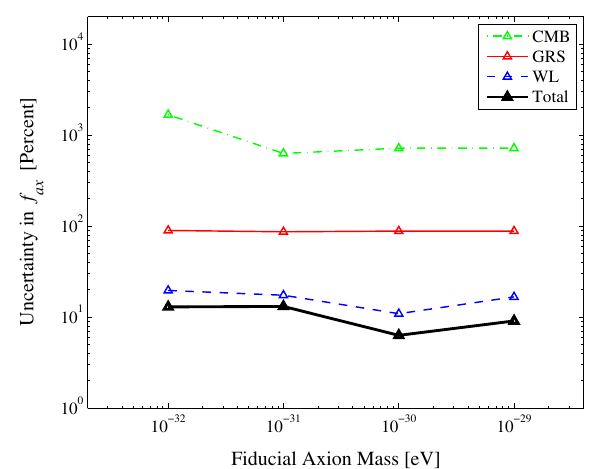
Fig. 50 Marginalized uncertainty in f ax for CMB (green), a galaxy redshift survey (red), weak lensing (blue) and the total (black) evaluated for four different fiducial axion masses, for the cosmology Λ CDM + f ax + ν . Image reproduced by permission from Marsh et al. (2012), copyright by APS